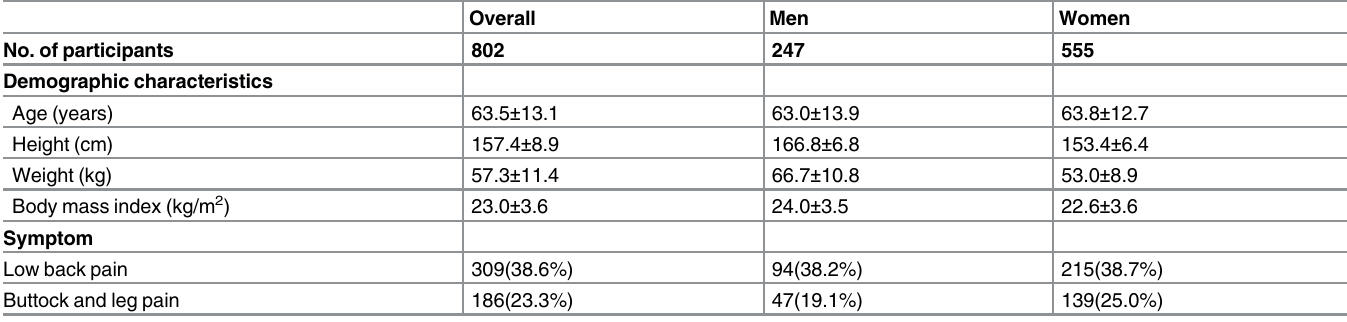
Table 1. Characteristics of